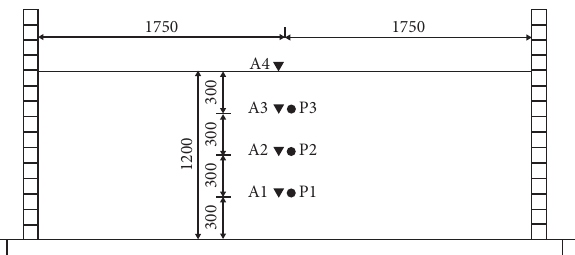
Figure 4: Arrangement of sensors embedded in observation section for shaking table test (units: mm) (A: accelerometer; P: earth pressure cell).